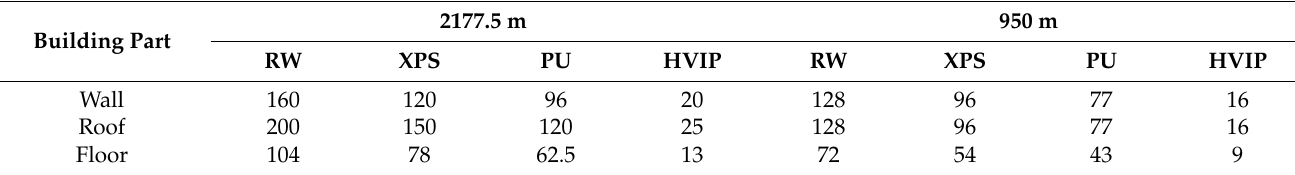
Table 5. Insulation material thicknesses for different parts of envelopes required under the NZEB